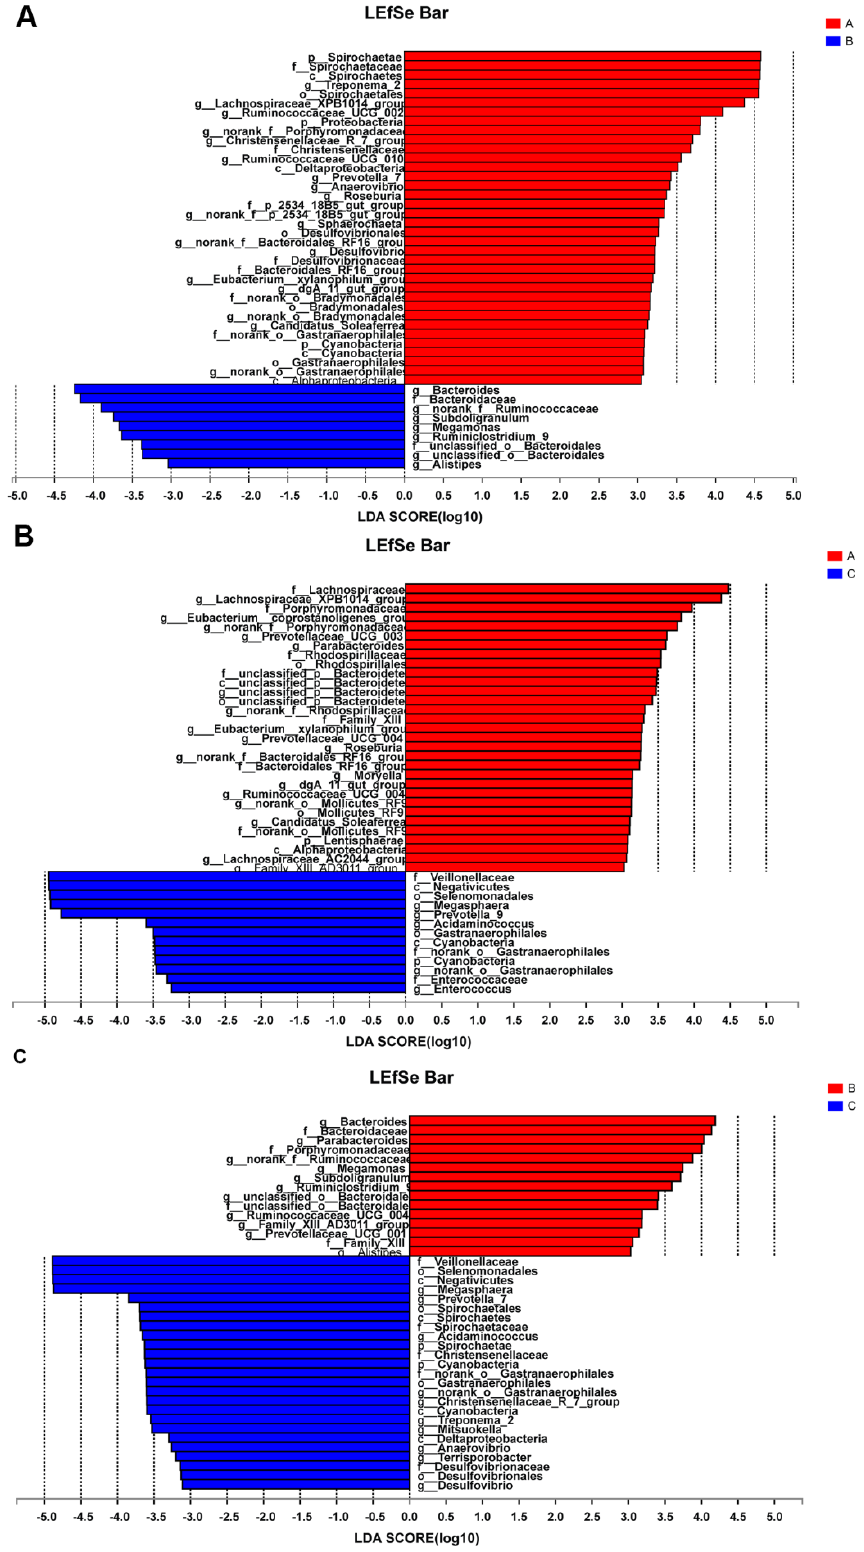
Figure 5. Linear Discriminant Analysis (LDA) on the genus level. Bacterial taxa at the genus level significantly identified by linear discriminant analysis coupled with e ff ect size (LEfSe) using the default parameters between groups A and B ( A ), between groups A and C ( B ), and between groups B and C ( C ), respectively. Group A: basal diet; group B: basal diet supplemented with antibiotics and zinc oxide; group C: basal diet supplemented with 0.06% CPB.